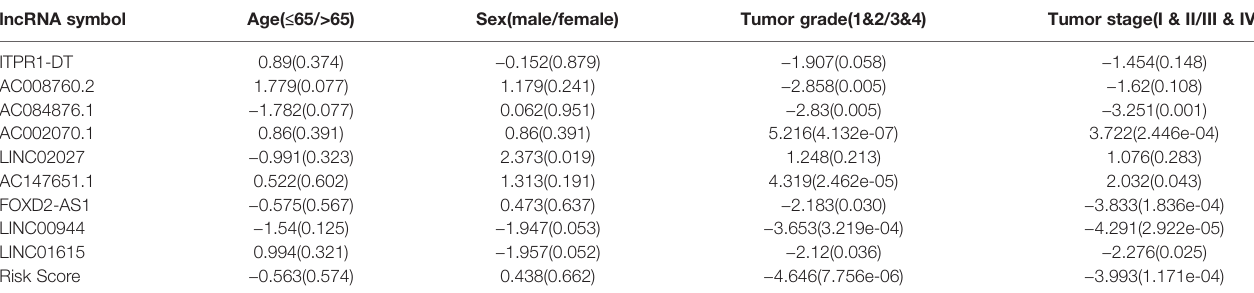
lncRNA, long non-coding